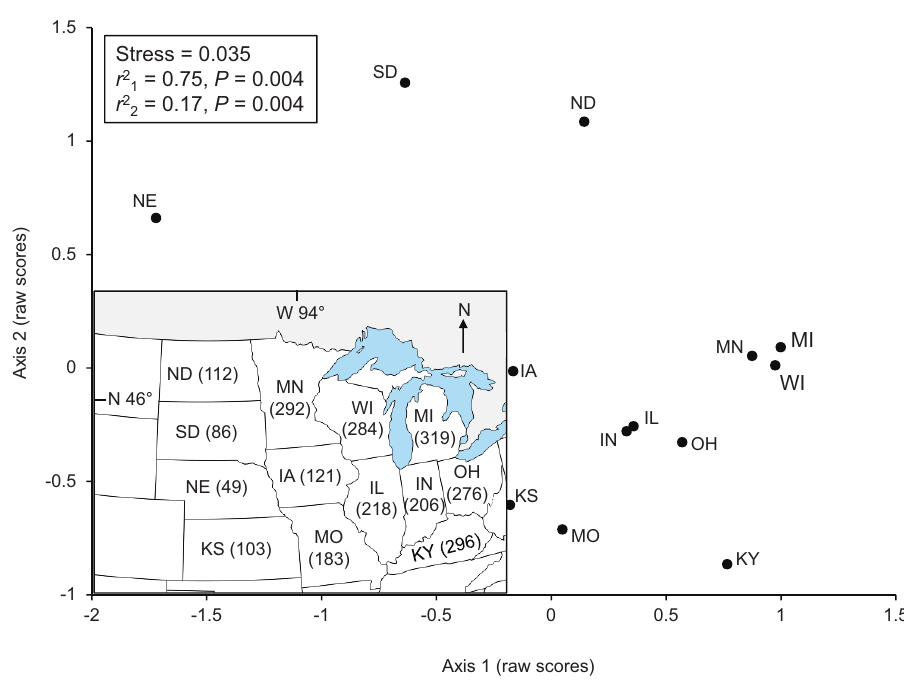
Figure 2. The 13 states of the Upper Midwest region delineated by location and by the results of an NMDS ordination of caddisfly species presence or absence per state. Total number of species for each state in parentheses. State abbreviations in Fig.